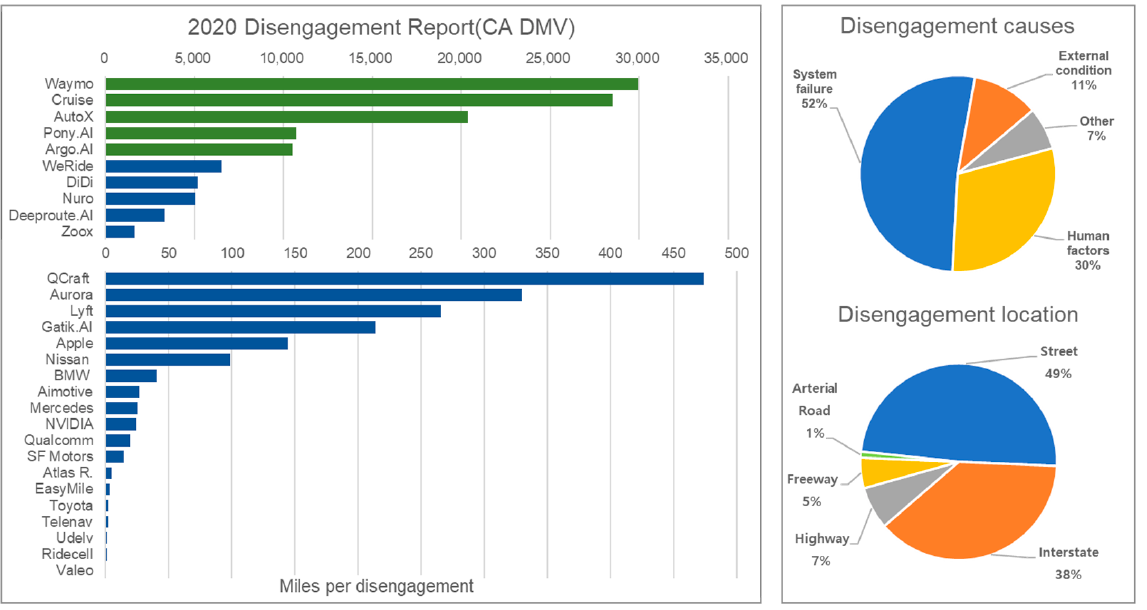
Figure 1. California DMV disengagement report summary [8,9] .